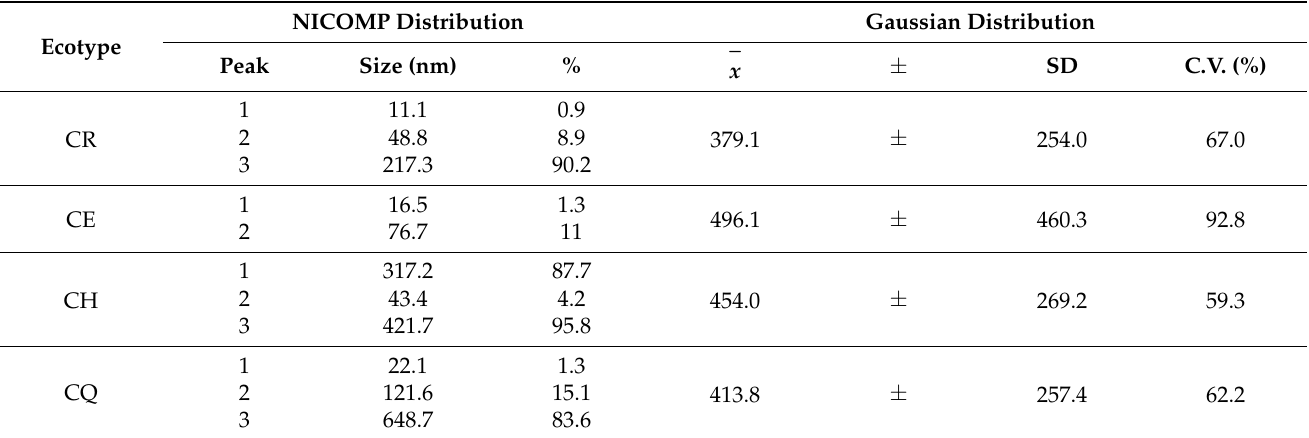
Table 8. Particle size (nm) of spray-dried nostoc.